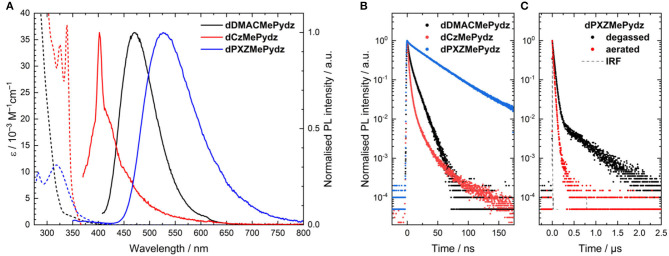
(A) Solution absorption (dashed lines) and emission spectra (solid lines) of the pyridazine-based compounds in toluene (λexc = 300 nm for dDMACMePydz, λexc = 360 nm for dCzMePydz, λexc = 315 nm for dPXZMePydz). Peak at 400 nm in emission spectra of dCzMePydz is an instrument artifact; (B) Time resolved photoluminescence spectra in degassed toluene (λexc = 378 nm); (C) Time resolved photoluminescence of dPXZMePydz in aerated and degassed toluene (λexc = 378 nm) at room temperature.